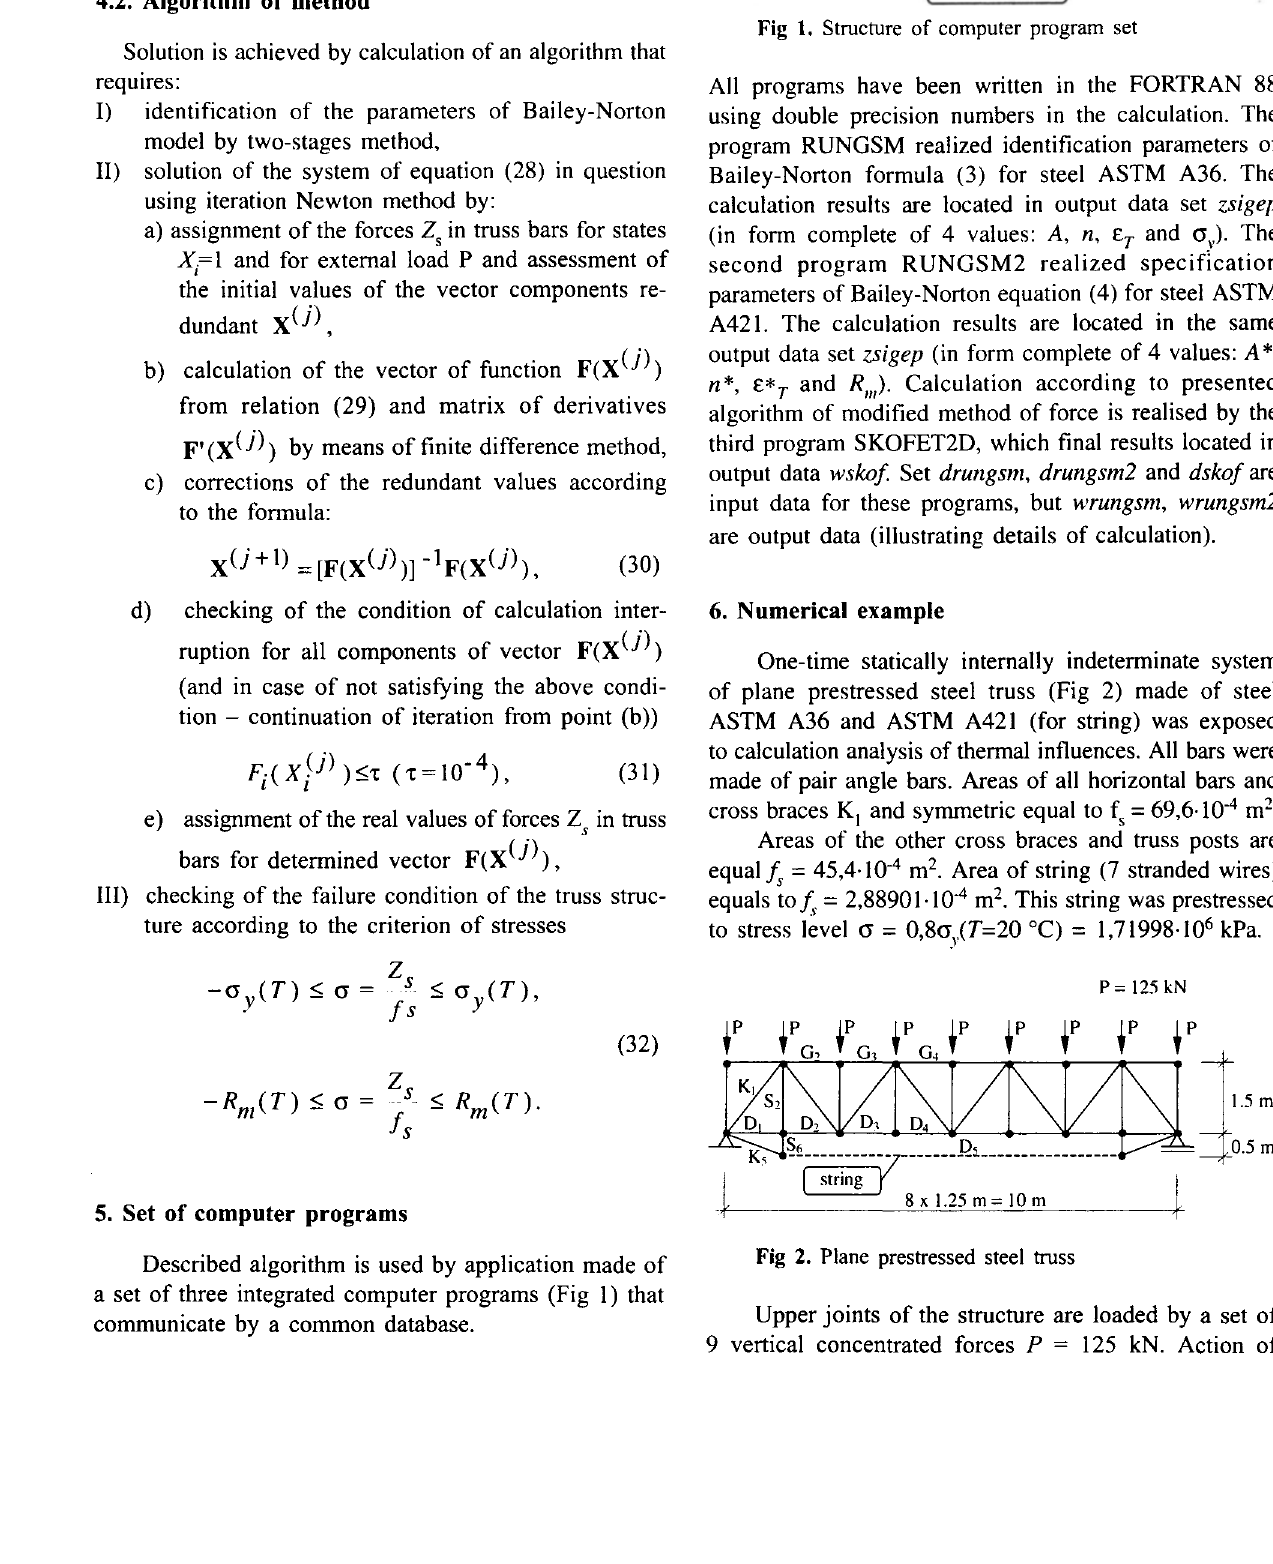
Fig 2. Plane prestressed steel truss Upper joints of the structure are loaded by a set of 9 vertical concentrated forces P = 125 kN. Action